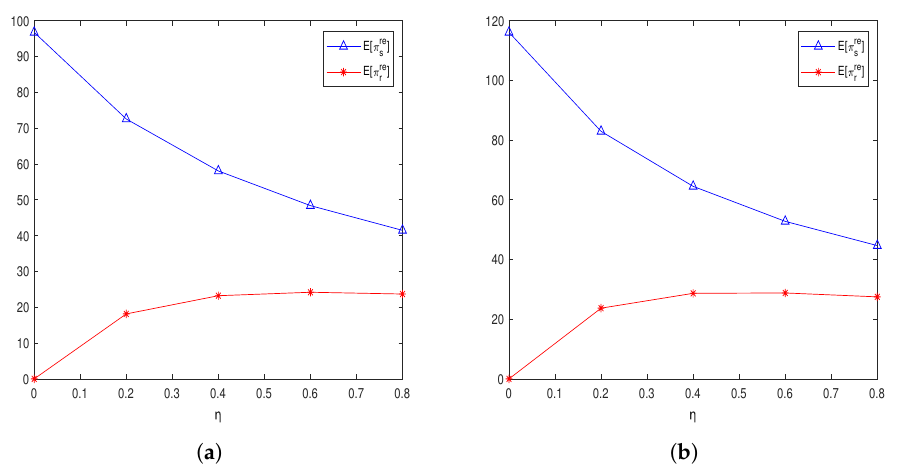
Figure 6. Impact of the revenue-sharing ratio η on the equilibrium profits. ( a ) ρ s = 0.8; ( b ) ρ s = 1.